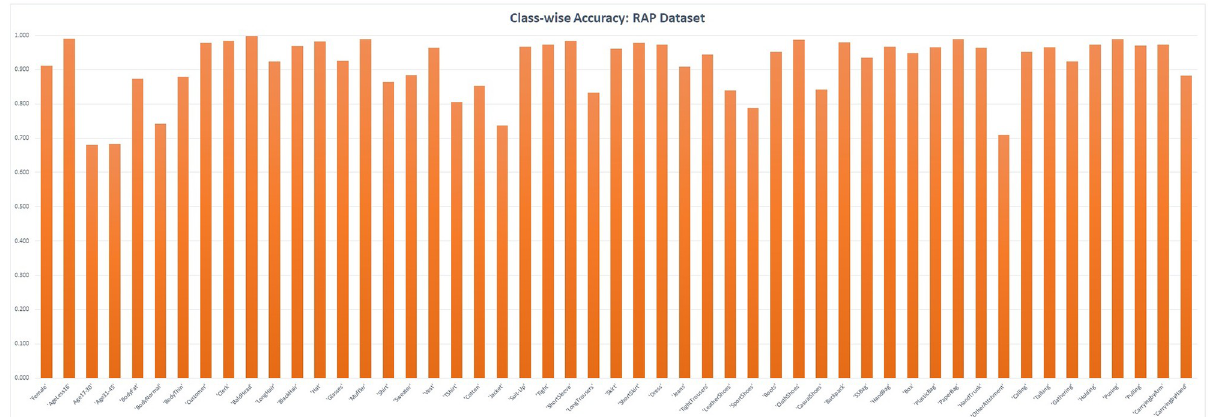
Fig 5. Class-wise accuracy—RAP dataset: The lowest accuracy is that of the classes: Age17–30, Age31–45 . The highest accuracy is for the class BaldHead .